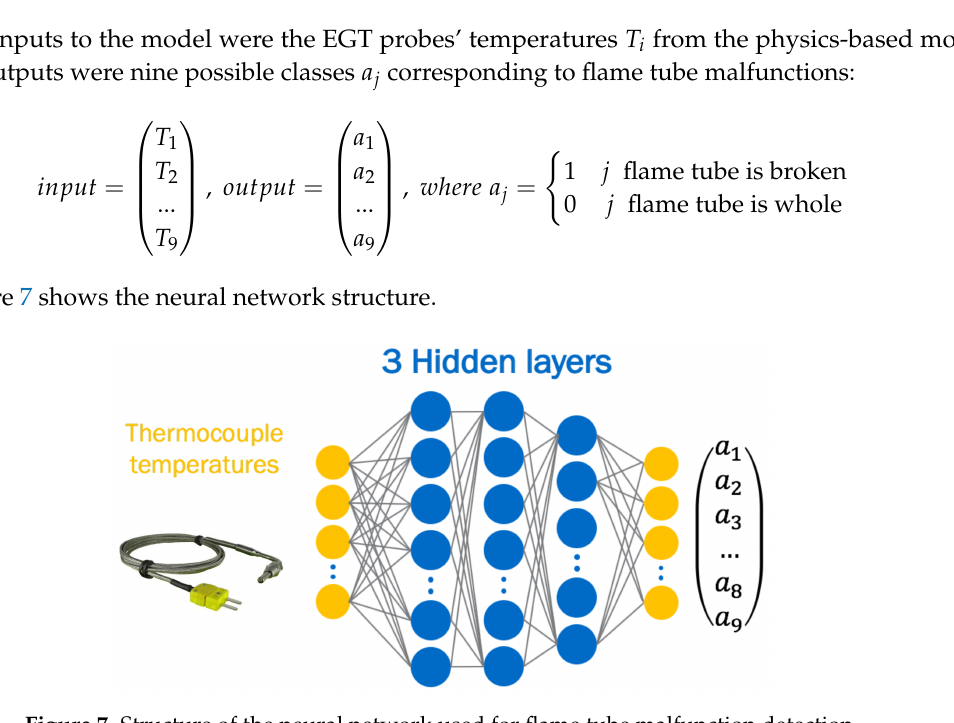
Figure 7. Structure of the neural network used for flame tube malfunction